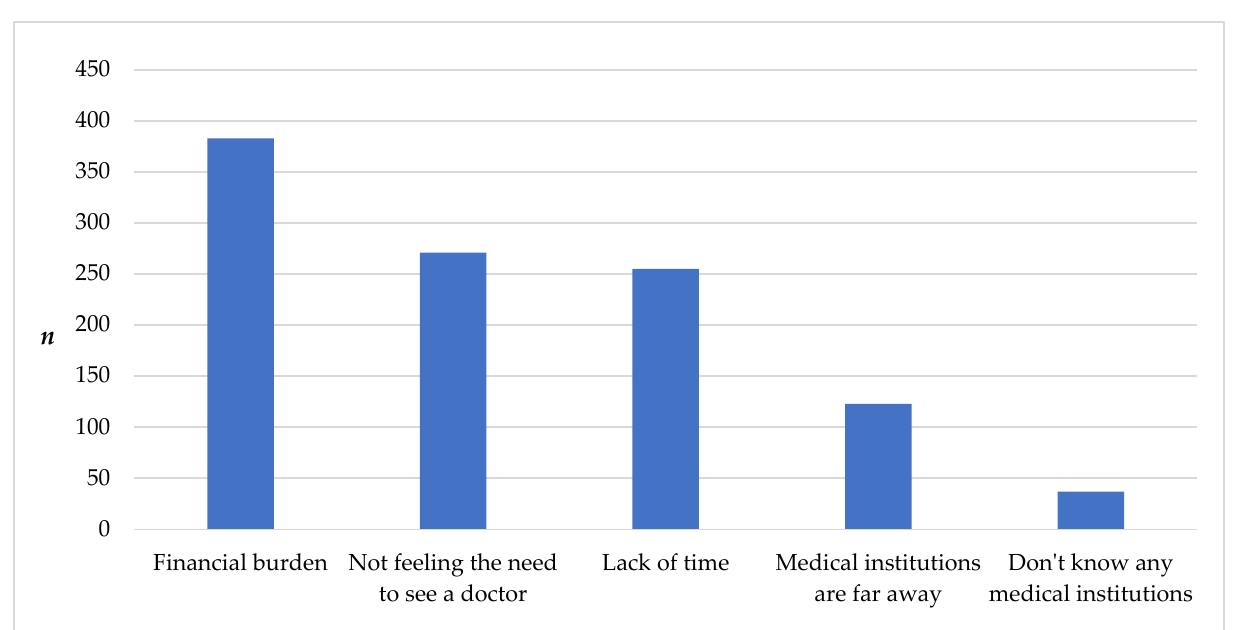
Figure 2. Reasons for HTTx noncompliance (multiple answers).